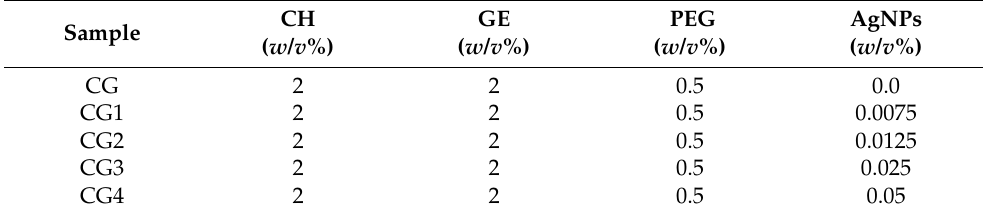
Table 1. Composition of polymer nanocomposite